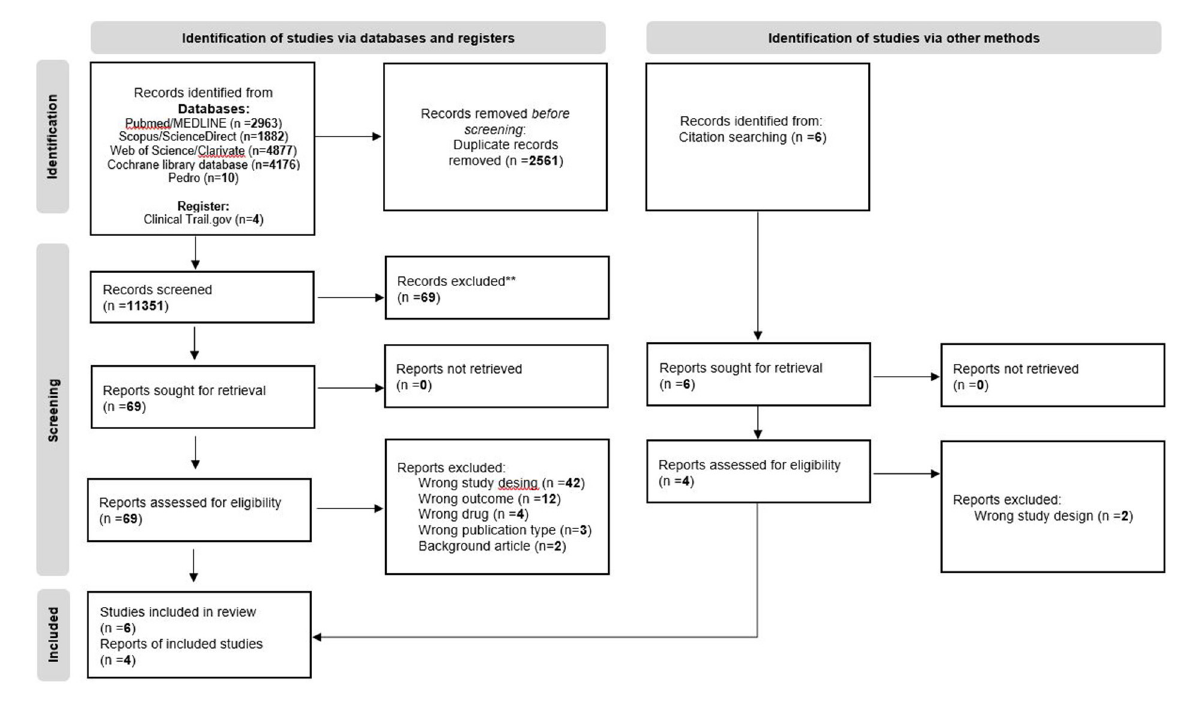
FIGURE1 PRISMA flow